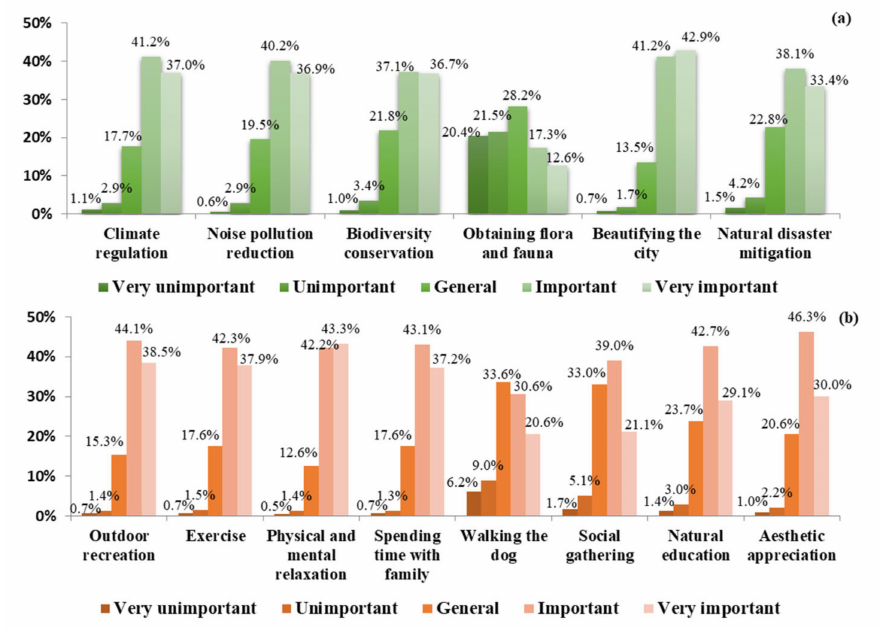
Figure 3. ( a ) The importance of the ecological services that respondents believe urban green spaces can provide; ( b ) the importance of the social services that respondents believe urban green spaces can provide.